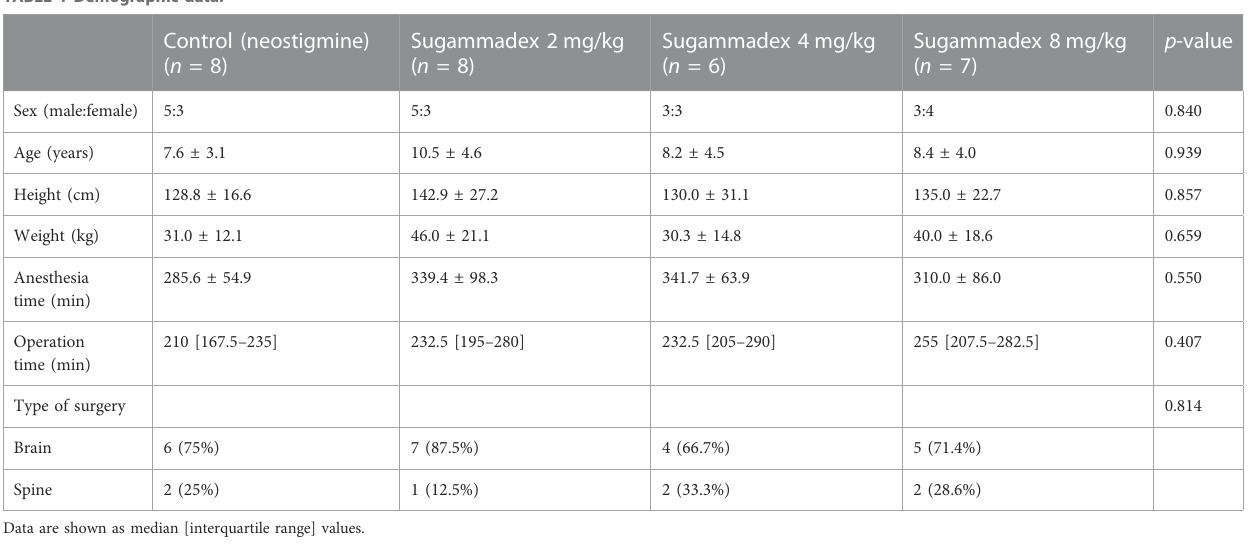
TABLE 1 Demographic data.